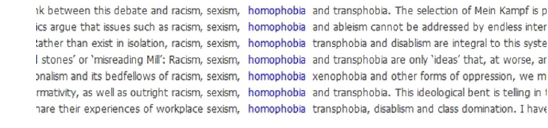
Fig. 2 Concordance for homophobia . 7 out of 21 lines found in the